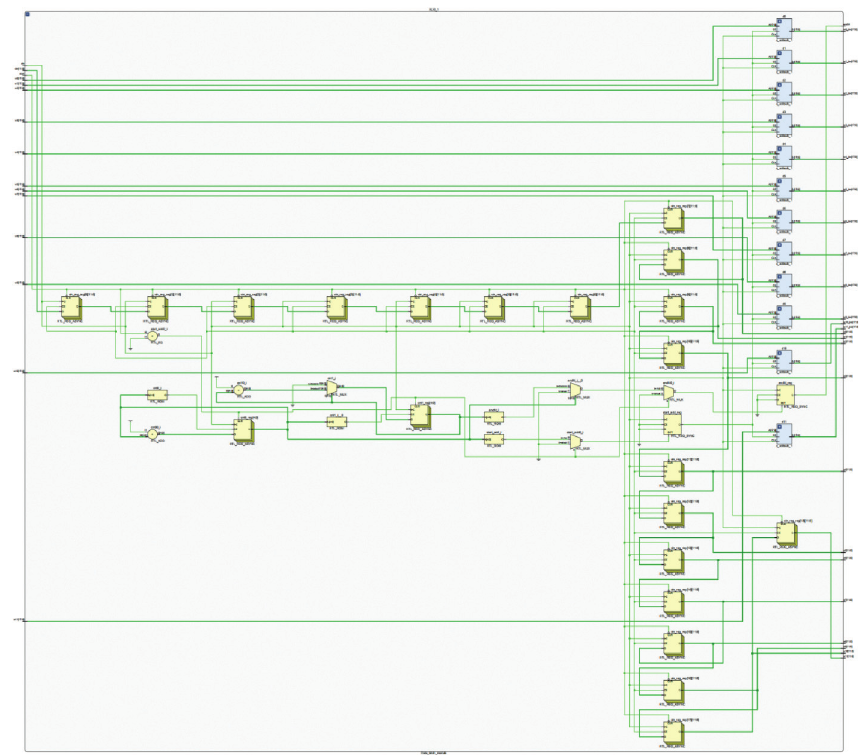
Figure 11: Integrated circuit diagram of the data latch